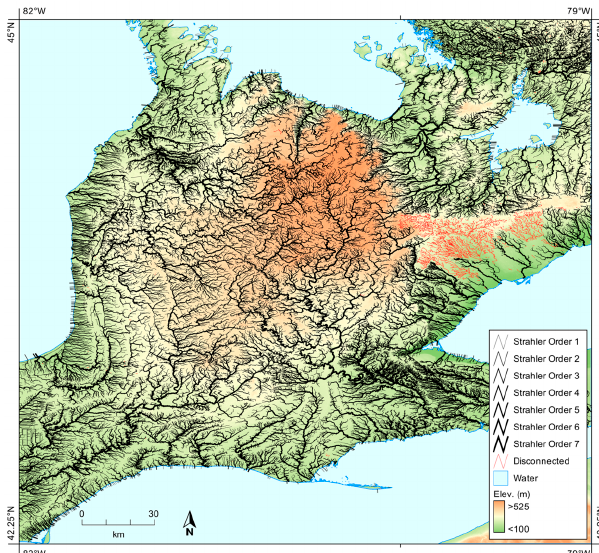
Figure 3. Southern Ontario study area drainage network with line thickness proportional to Strahler stream